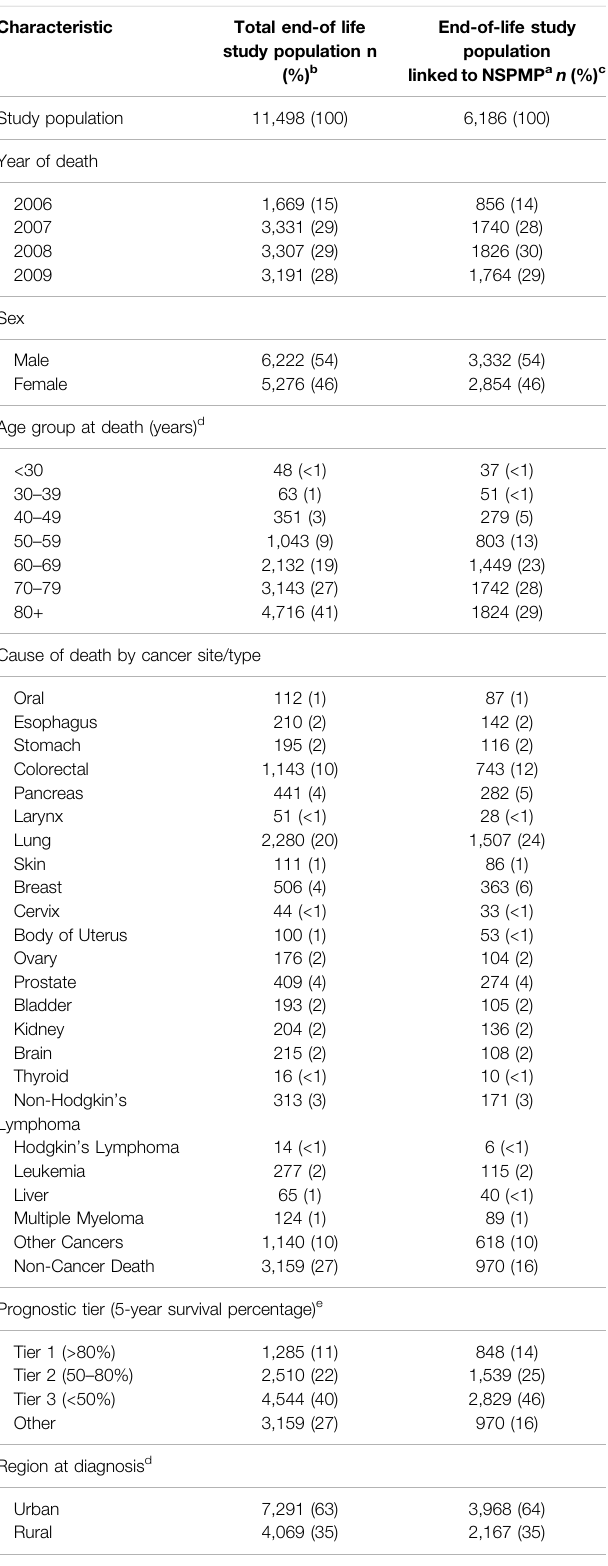
TABLE1| Demographicandclinicalcharacteristics oftheend-of-lifecancerstudy populations in Nova Scotia from 2005 – 2009.